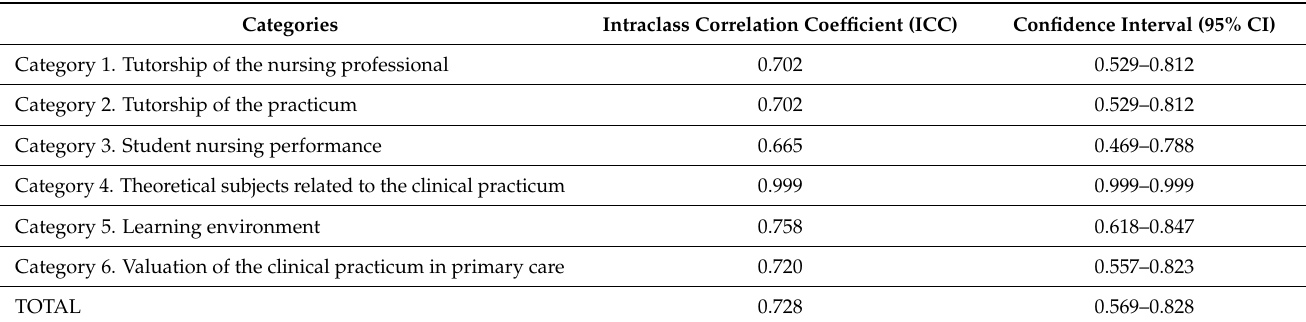
Table 4. Test-retest Intraclass Correlation Coefficient (ICC) of the Questionnaire of Perception toward the Clinical Learning Process